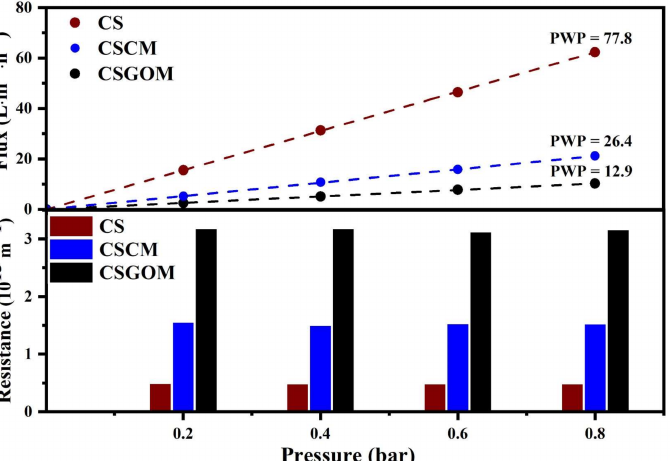
Figure 6. Variation of pure water flux, permeability, and resistance of CS, CSCM and CSGOM at 25 ◦ C. CSCM: 10% wt. of Matrimid and CSGOM: 1 mg · mL − 1 of